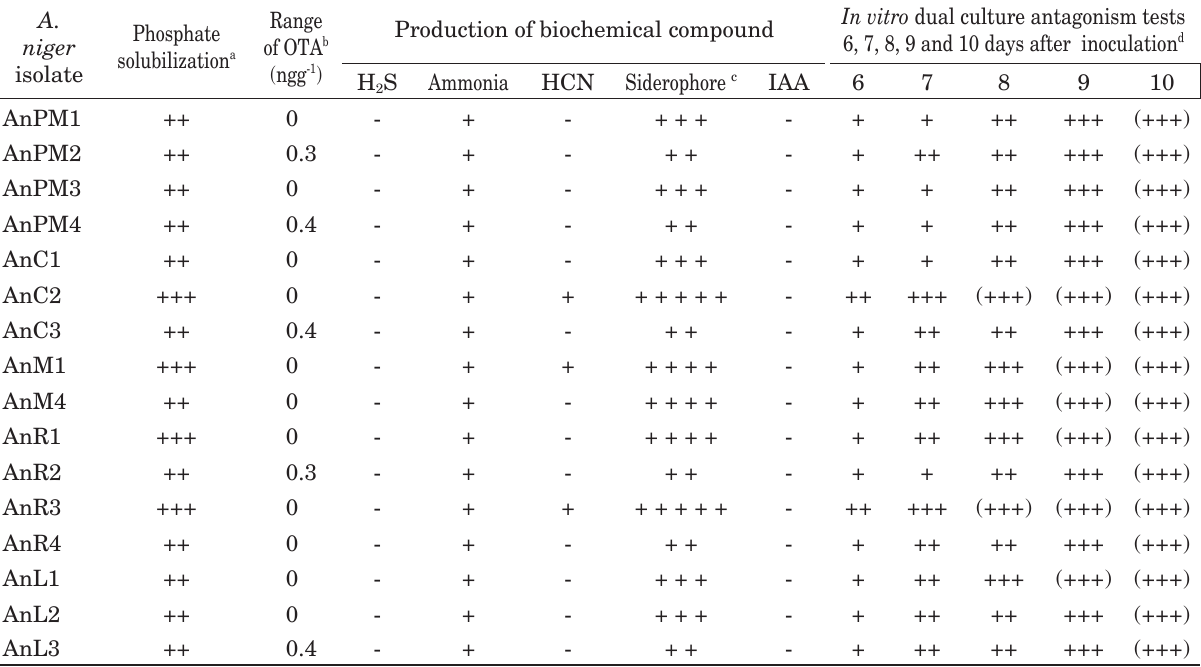
3. Some biochemical characters of Aspergillus niger isolates and in vitro antagonism against Rhizoctonia solani. Each value is the mean of fi ve